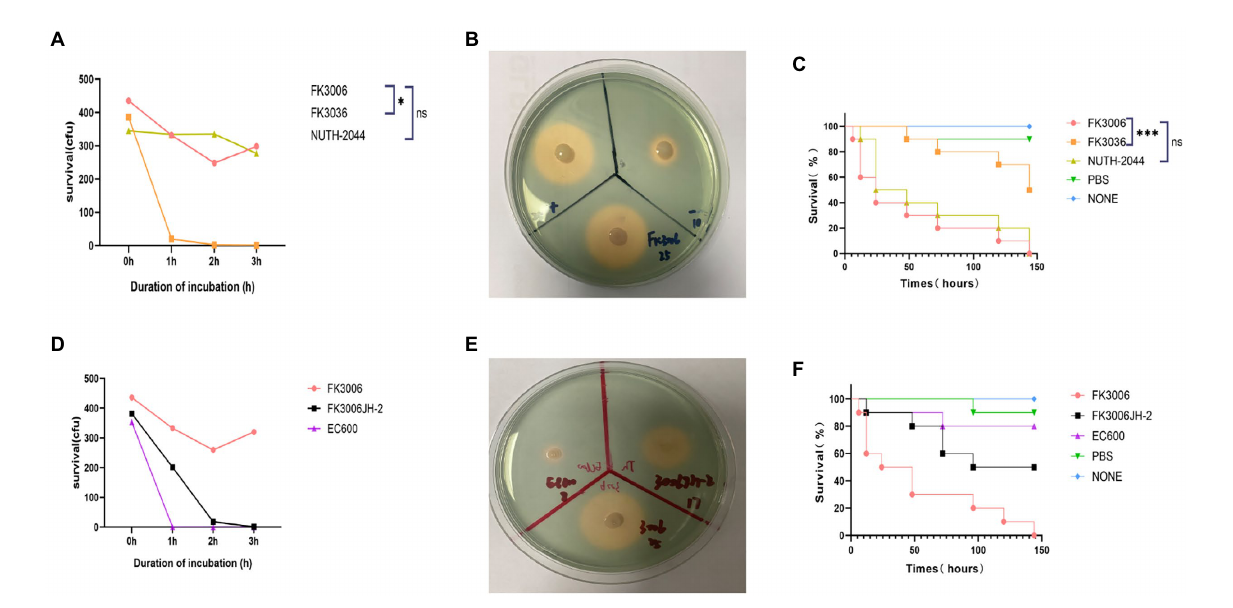
FIGURE 3 The virulence analysis of FK3006. (A) Serum killing assay of FK3006, FK3036 and NUTH-K2044 strains. Survival of each strain was evaluated by enumerating viable counts on MHA agar plate for 0, 1, 2, and 3 h of incubation in the pooled human serum at 37 ° C. There was a difference ( p < 0.05) in the growth of the strain FK3006 and FK3036 * p < 0.05. (B) Siderophore production of FK3006, FK3036 and NTUH-K2044. FK3036 and NUTH-K2044 were used as negative and positive control, respectively. An orange halos zone indicated Siderophore production. (C) Survival rates of G. mellonella infected with FK3006, FK3036, NUTH-K2044, PBS, and none. Log-rank Mantel-638 Cox test was performed for analysis of the indicated curves. A difference ( p < 0.001) was observed between FK3006 and FK3036 *** p < 0.001. (D) Serum killing assay of FK3006, FK3036JH-2 and EC600 strains.